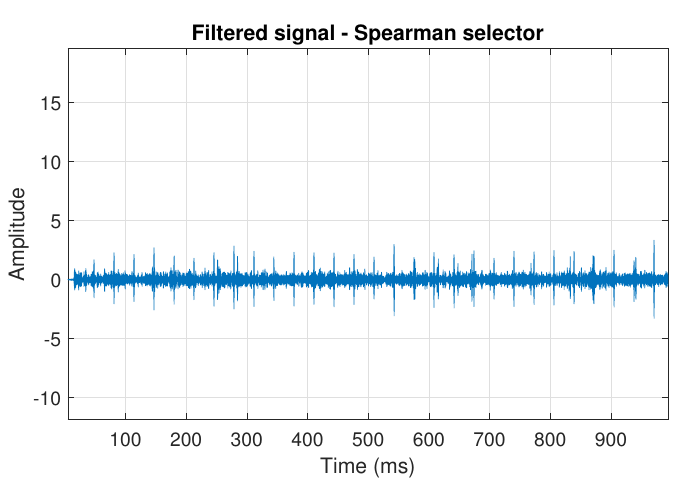
Figure 18. Filtered signal s 2 by Spearman